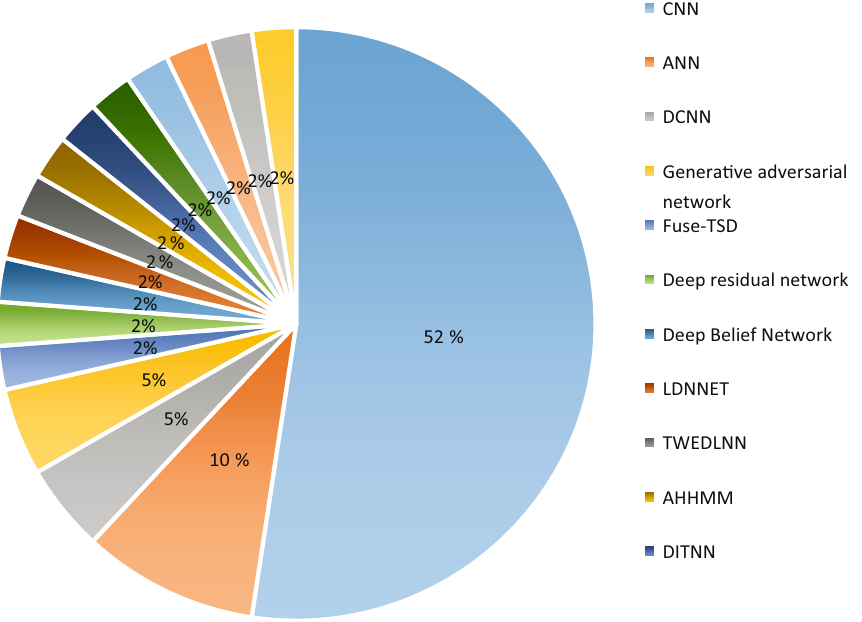
Figure 5: Distribution ratios for deep learning algorithms.